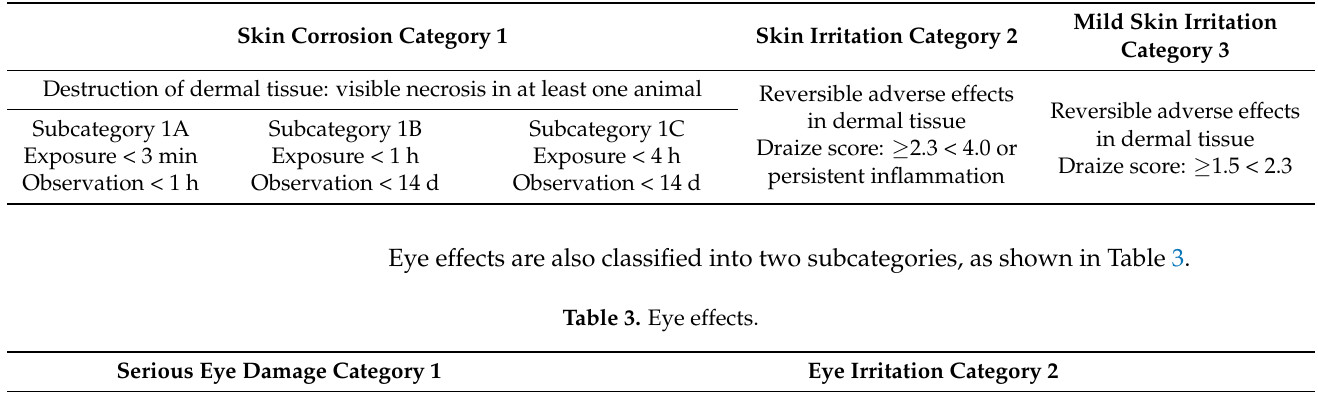
Table 2. Skin corrosion and irritation.